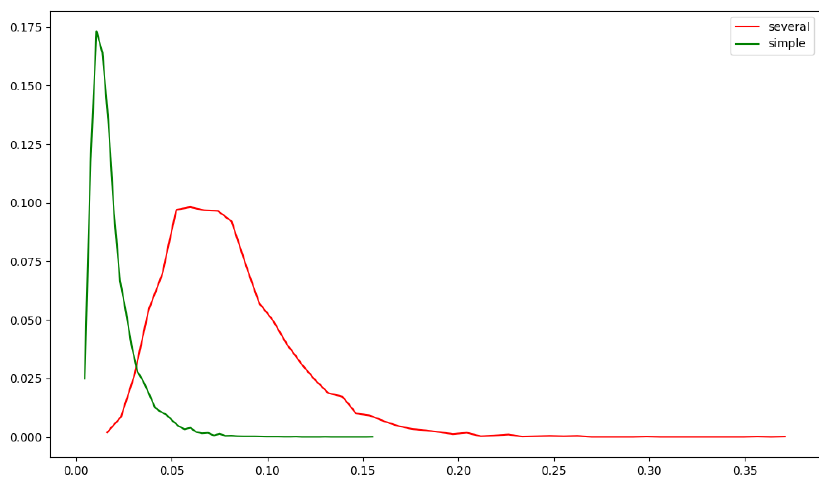
Figure 14. Statistical results of building discriminant errors.